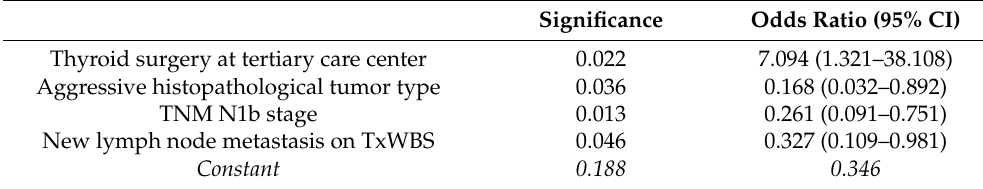
Table 4. Multivariable logistic regression model showing independent predictors of a successful treatment at nine